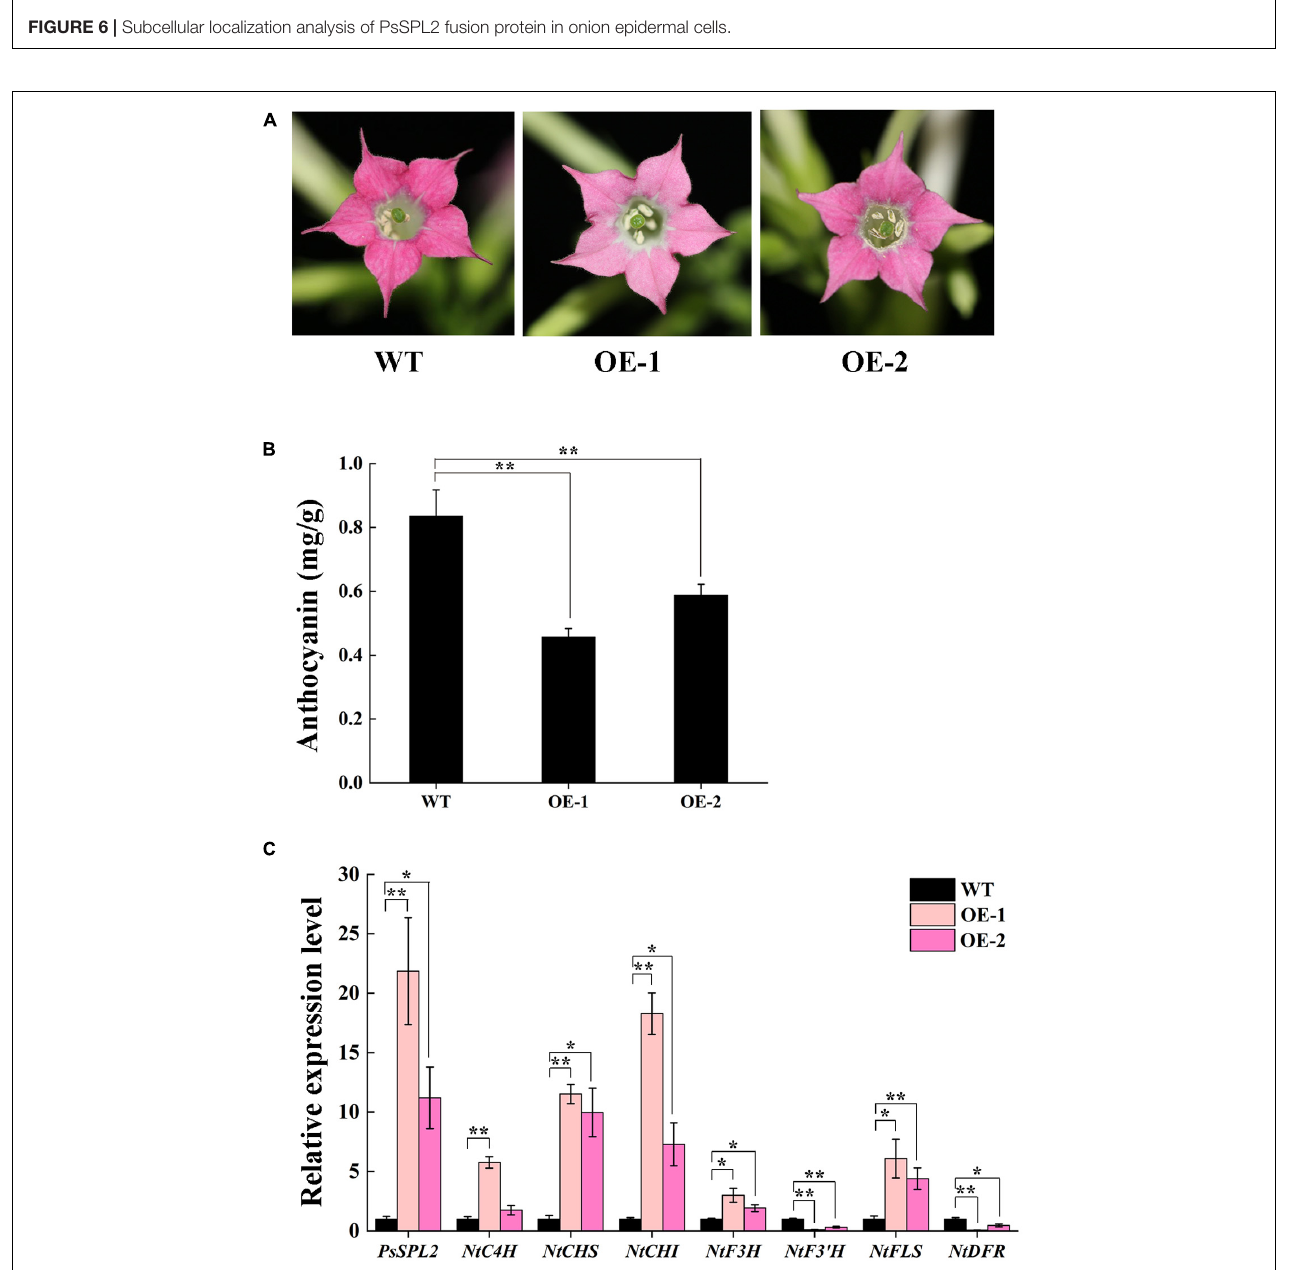
FIGURE 7 | Overexpressing of PsSPL2 in tobacco. (A) Flowers from wild-type (WT) and transgenic tobacco plants (OE-1 and OE-2). (B) Anthocyanin contents in petals of WT and transgenic tobacco plants. (C) Expression patterns of endogenous flavonoid biosynthetic genes in the petals of WT and transgenic tobacco plants. Error bars represent standard error of the mean from three biological replicates. ** P < 0.01, * P < 0.05.